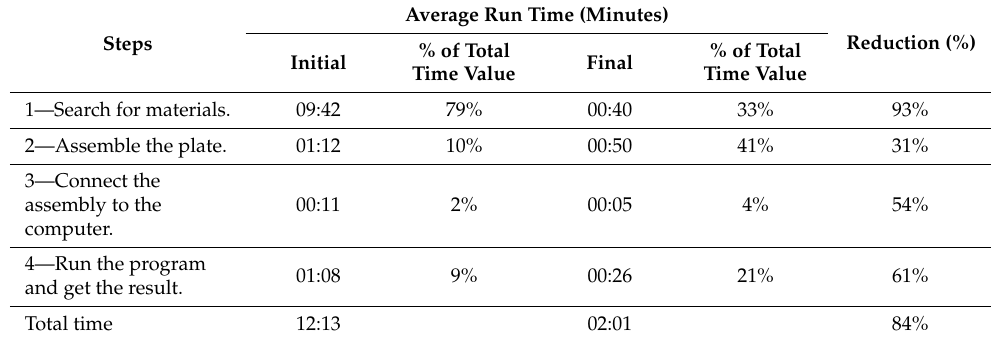
Table 4. Reductions obtained in the experimental procedure run